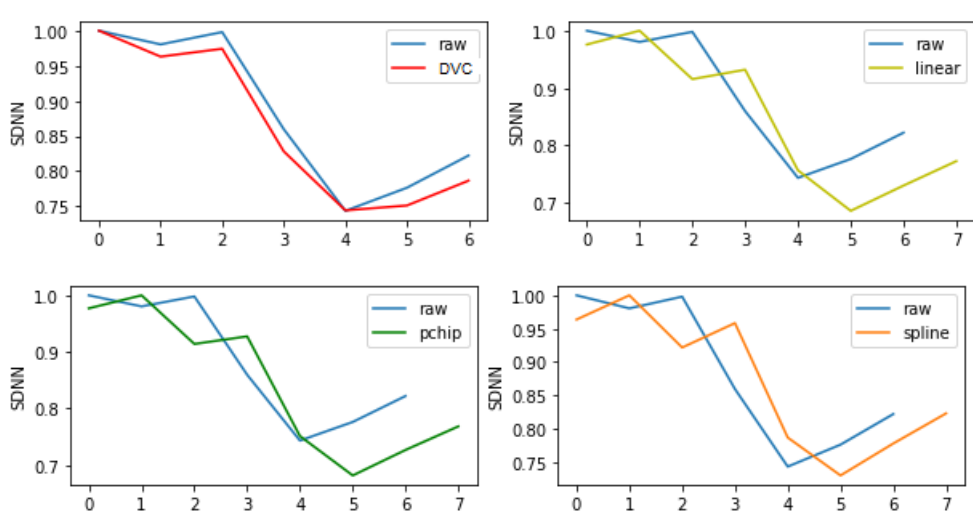
Figure 7. Example of standardized SDNN extracted from the raw and reconstructed signals of 10 min